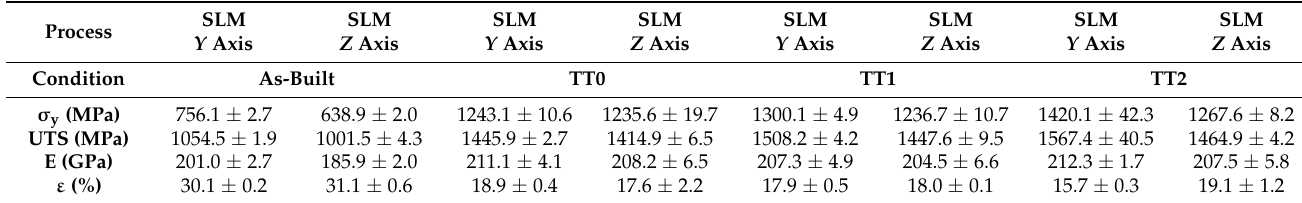
Table 4. Summary of mechanical properties for IN718 alloy obtained by